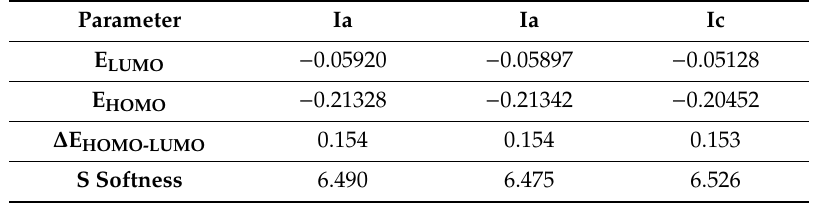
Table 5. Frontier molecular orbital (FMO) energies a.u., and softness of all isomers ( Ia – c ).